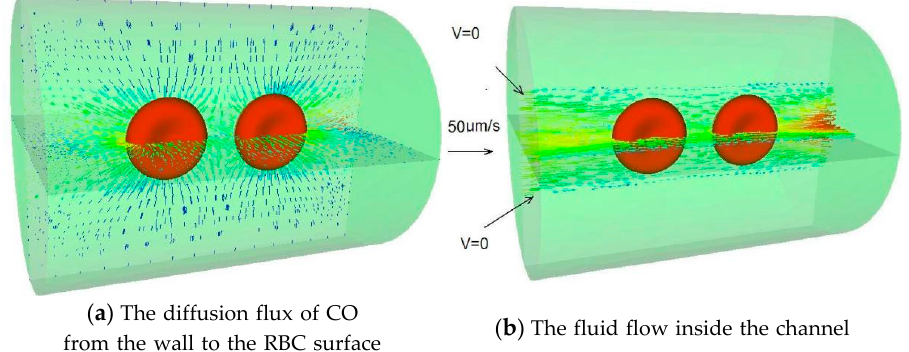
Figure 2. The finite element mesh of a pulmonary vessel and the uptake of CO in a pulmonary vessel.